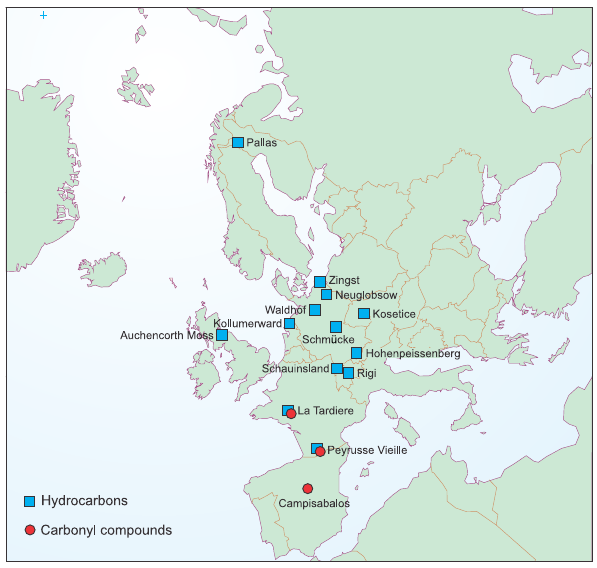
Fig. 11. The EMEP VOC monitoring stations in operation in 2009 (adopted from Solberg,